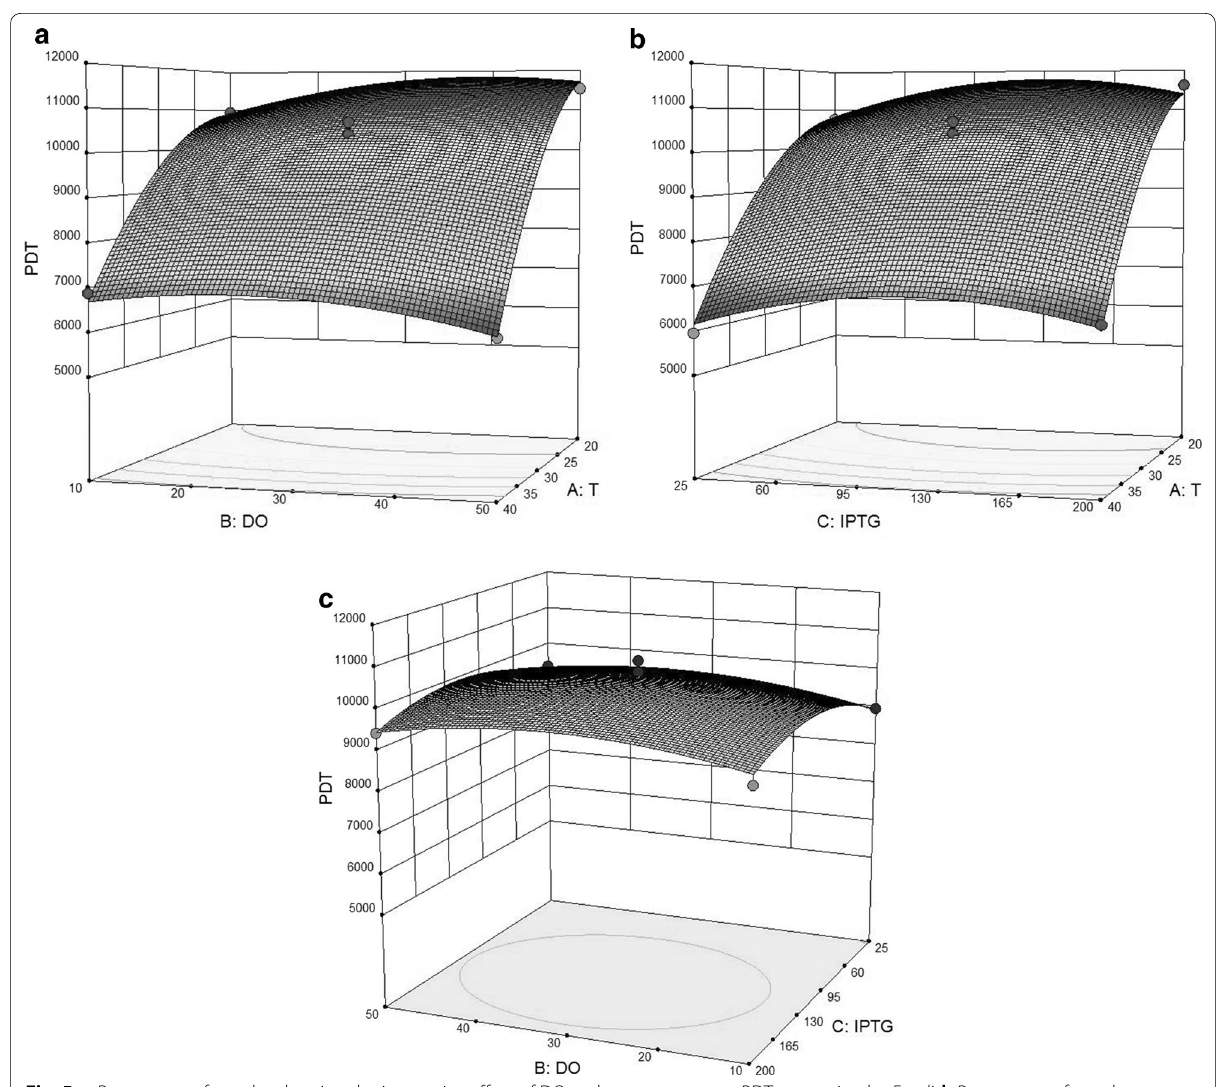
Fig. 5 a Response surface plot showing the interactive effect of DO and temperature on rPDT expression by E. coli . b Response surface plot showing the interactive effect of IPTG and temperature on rPDT expression by E. coli . c Response surface plot showing the interactive effect of DO and IPTG on rPDT expression by E.